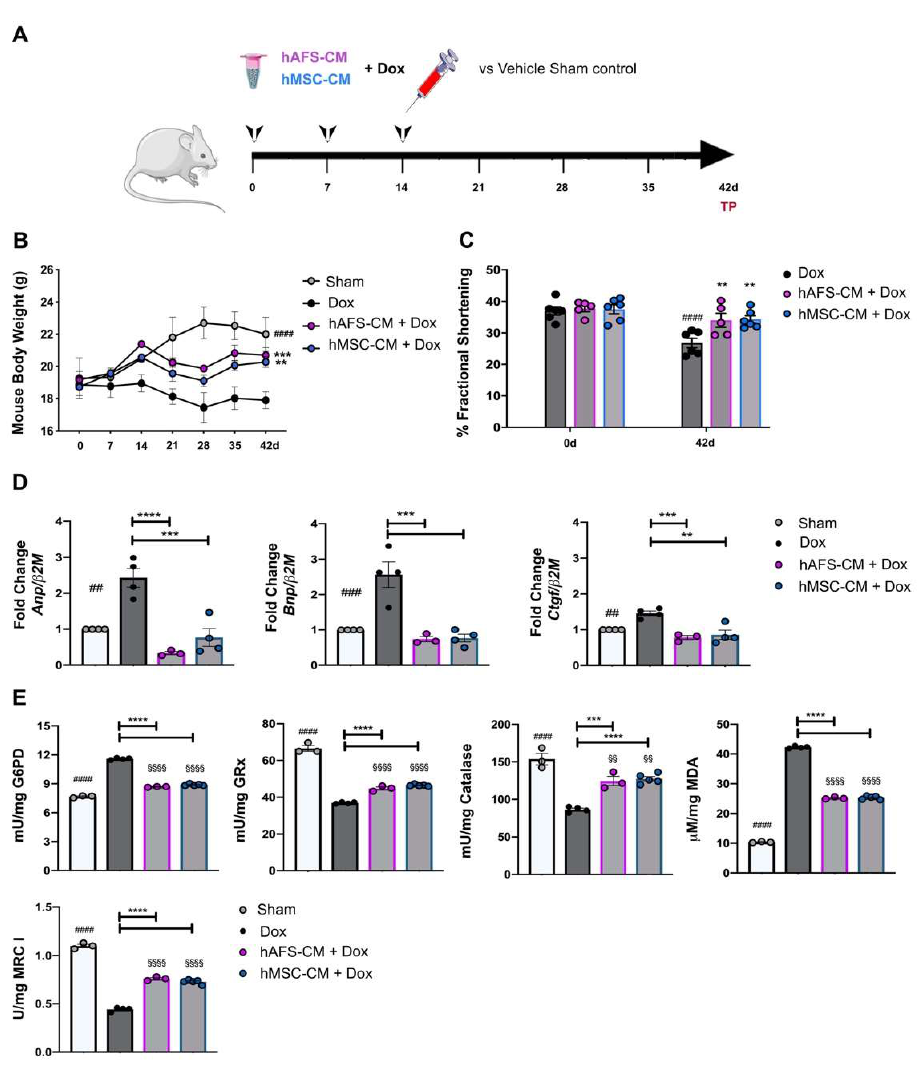
Figure 5. hAFS and hMSC secretomes exert long-term cardioprotective effects in a preclinical mouse model of Dox-induced cardiomyopathy. ( A ) Schematic of the experimental design for in vivo experiments; a cumulative 12 mg/Kg Dox dose was administered by intra-peritoneal delivery three times, once a week, over 14 days (4 mg/kg on days 0-7-14). The hAFS-CM and hMSC-CM (100 µ g/mouse) were administered 3 h before each 4 mg/kg Dox injection. ( B ) Evaluation of mice body weight over time in sham healthy control animals ( n = 3, Sham : day 0: 19.27 ± 1.27 g; day 42: 22.03 ± 1.03 g) and in mice receiving Dox with or without ( n = 4, Dox : day 0: 18.85 ± 0.83 g; day 42: 17.90 ± 0.52 g) pre-incubation with hAFS-CM ( n = 6, hAFS-CM + Dox : day 0: 19.16 ± 0.15 g; day 42: 20.70 ± 0.47 g) or hMSC-CM ( n = 5, hMSC-CM + Dox : day 0: 18.72 0.53 g; day 42: 20.28 0.33 g). Values are expressed as the mean SEM of the different animals. Sham vs. Dox at day 42: #### p < 0.0001; hAFS- CM + Dox vs. Dox at day 42: *** p = 0.0008 and hMSC-CM +Dox vs. Dox at day 42: ** p = 0.0083. ( C ) Ultrasound analysis of cardiac function via evaluation of fractional shortening percentage over time in mice receiving a cumulative dose of 12 mg/Kg Dox with or without ( n = 6, Dox : day 0: 37.0 1.30% vs. day 42: 26.80 ± 1.30%) pre-incubation with hAFS-CM ( n = 5, hAFS-CM + Dox : day 0: 37.80 1.02%; day 42: 34.01 2.20%) or hMSC-CM ( n = 6, hMSC-CM + Dox : day 0: 37.50 1.44%; day 42: 34.30 1.20%). Values are expressed as the mean ± SEM of the independent animals. Dox day 0 vs. day 42: #### p < 0.0001; hAFS-CM + Dox vs. Dox at day 42: ** p = 0.0055 and hMSC-CM +Dox vs. Dox at day 42: ** p = 0.0026. ( D ) Real time qRT-PCR analysis on murine myocardial tissue 42 days after starting Dox administration with or without ( Dox , n = 4) pre-treatment with hAFS-CM ( hAFS-CM + Dox , n = 3) or hMSC-CM ( hMSC-CM+ Dox , n = 5) versus sham healthy control mice ( Sham , considered as calibrator, n = 4) for the fold-change expression of Anp (Atrial natriuretic peptide; Dox : 2.43 ± 0.22; hAFS-CM + Dox : 0.34 ± 0.03; hMSC-CM+Dox : 0.77 ± 0.21), Bnp (Brain natriuretic peptide; Dox: 2.56 ±